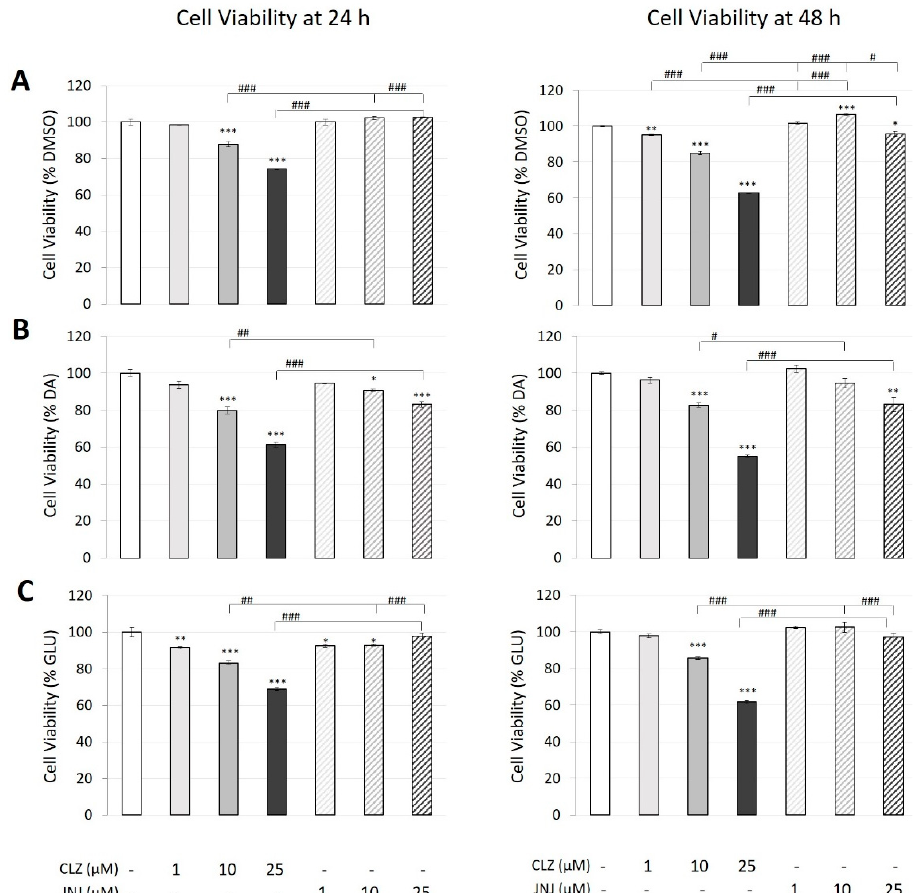
Figure 1. Effects of different concentrations (1, 10 and 25 µ M) of clozapine (CLZ) and JNJ-46356479 (JNJ) alone ( A ), in combination with dopamine (DA) at 100 µ M ( B ) and in combination with glutamate (GLU) at 80 mM ( C ) on the viability of SK-N-SH cells after 24 h and 48 h as measured by Alamar Blue ® assays. The values represent percentages of the control (DMSO-treated), DA-treated or GLU-treated cells and are expressed as means ± S.E.M (n = 3). Two-way ANOVA was performed to assess the drug treatment and concentration effect, and Bonferroni’s post hoc test was used for pair comparisons. * p ≤ 0.05, ** p ≤ 0.01, *** p ≤ 0.001 vs. control. # p ≤ 0.05, ## p ≤ 0.01, ### p ≤ 0.001 included in square brackets indicate comparisons between CLZ and JNJ.